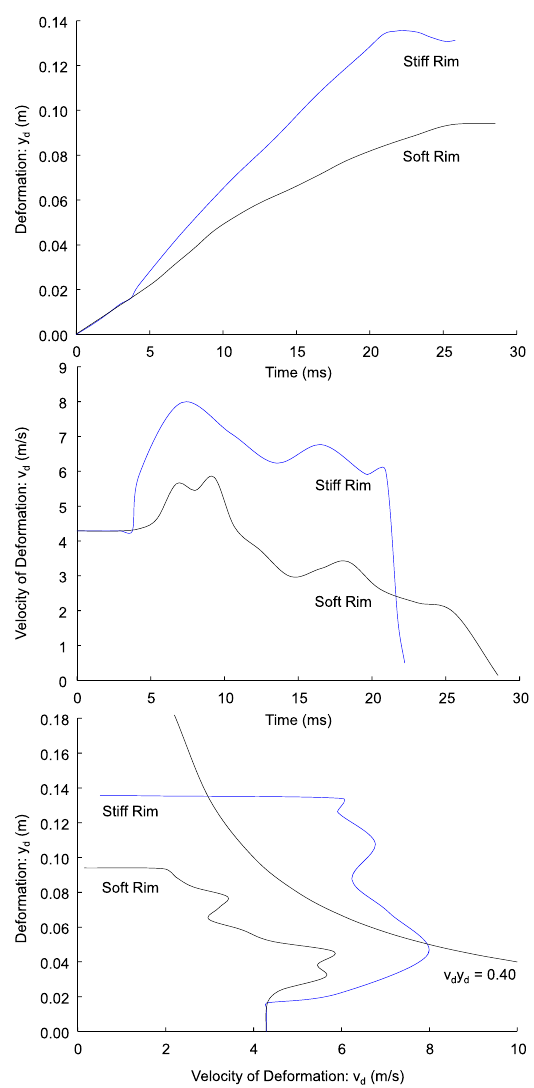
Figure 16. Abdominal compression tests with stiff and soft rim (based on Lau et al. 58